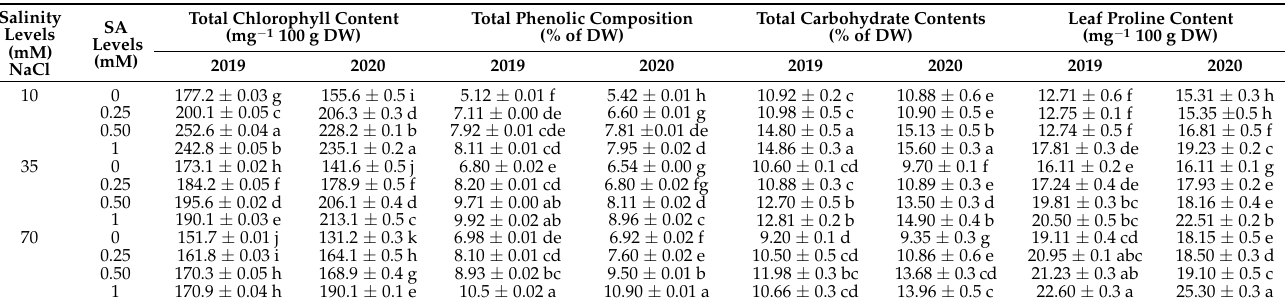
Table 3. Means of total chlorophyll content, leaf total phenolic composition, total carbohydrates, and proline contents of pomegranate plants in response to foliar salicylic acid (SA) treatments under salinity stress conditions.